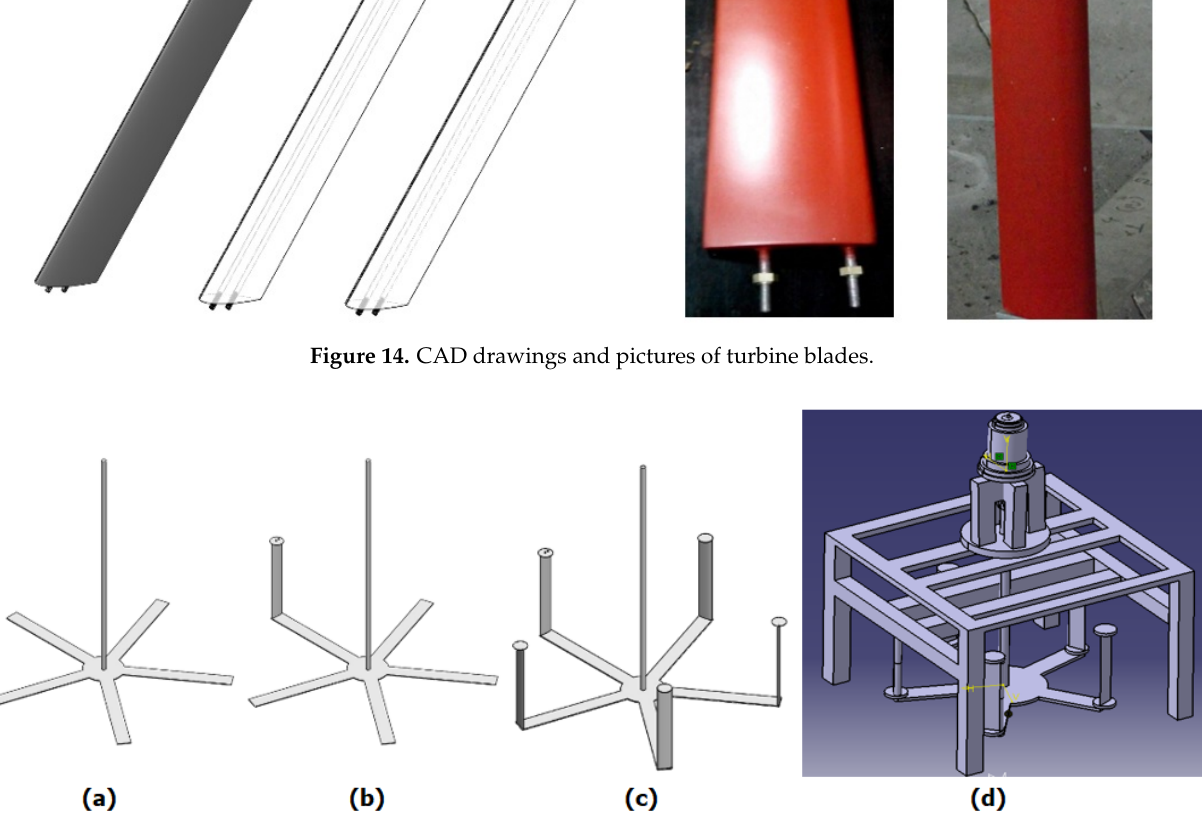
Figure 14. ( a – c ) Assembly steps of the turbine, ( d ) complete assembly CAD.